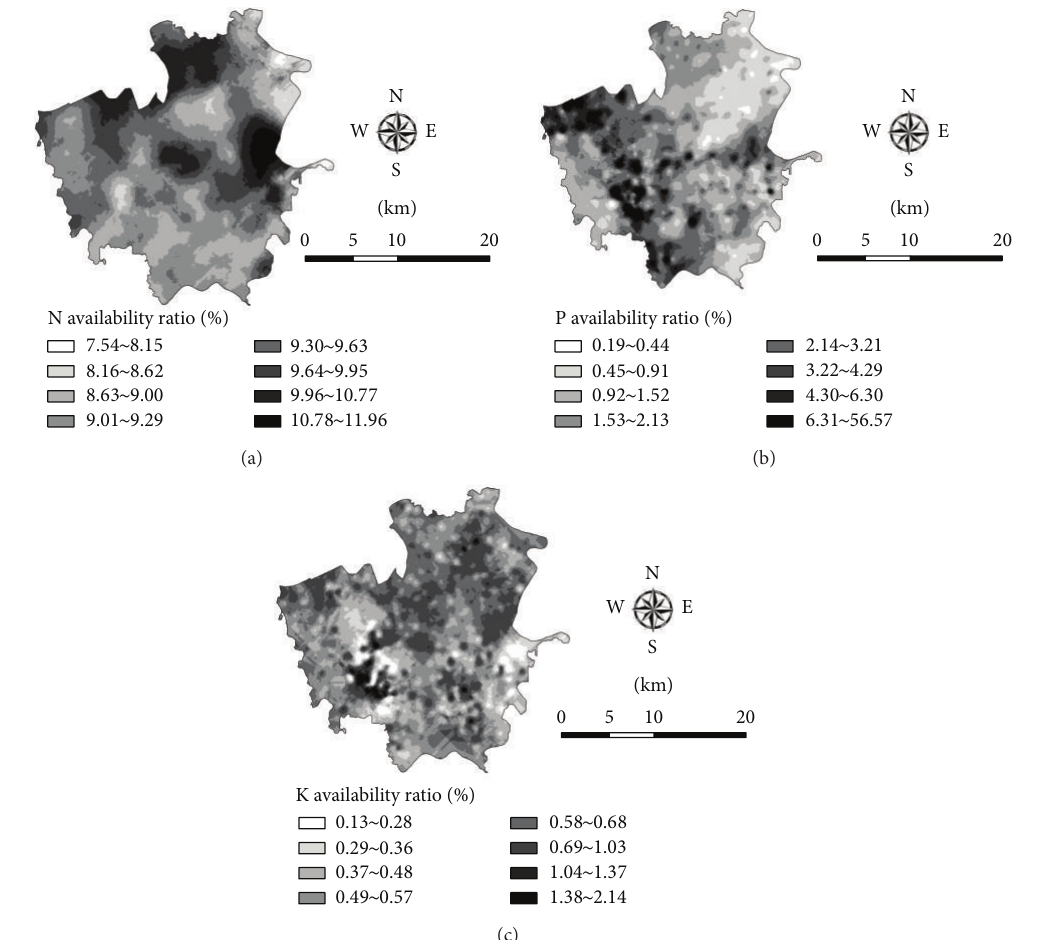
Figure 5: Spatial distribution maps of availability ratios of N (a), P (b), and K (c). Note that (a) is derived from Figures 4(a) and 4(b), (b) is derived from Figures 4(c) and 4(d), and (c) is derived from Figures 4(e) and